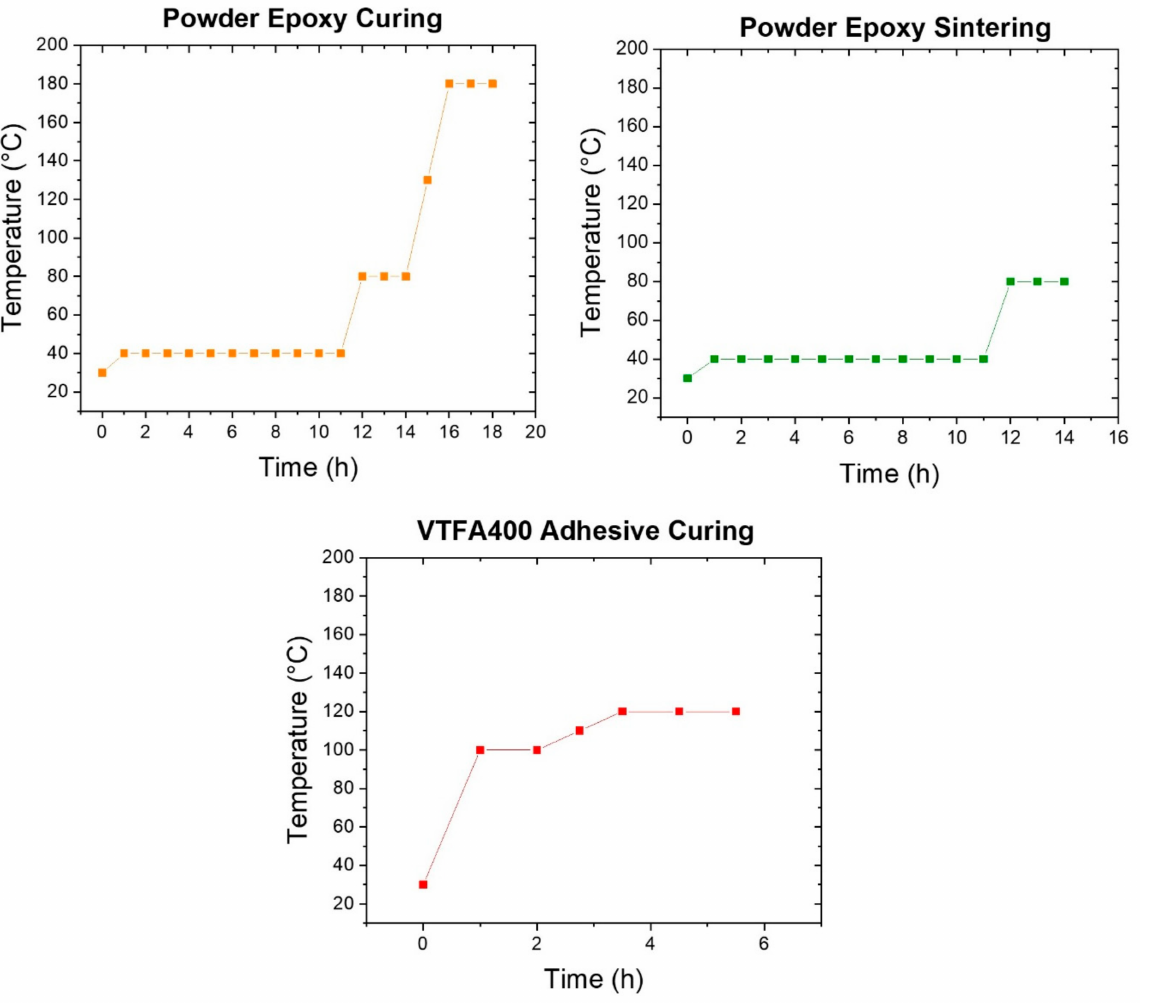
Figure 3. Curing and sintering cycles for powder epoxy and VTFA400 adhesive. The plates were then cut in half at 90 ◦ to the longitudinal direction and the edges were trimmed (step 4). At this stage, Z-pinning of two sintered half plates was completed, outlined in detail in Section 2.2.3. Plates were then placed in a PTFE covered steel mold fitting the ISO 4587 dimensions (step 5a + 5b). Figure 4 shows the sintered half plate inside the PTFE covered steel